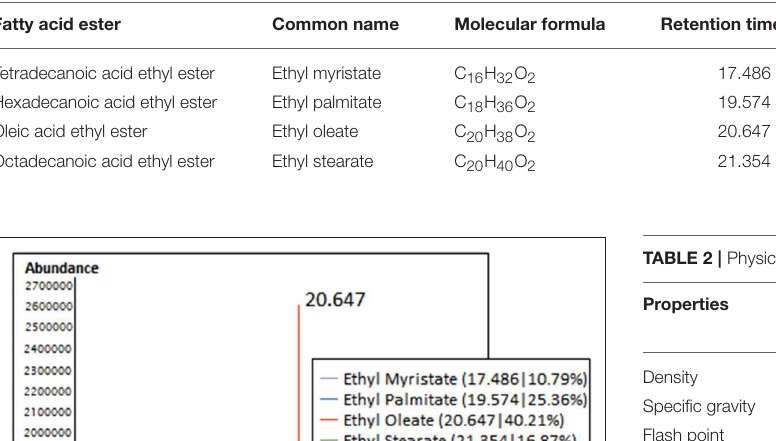
TABLE 1 | Availability of characterized dominant fatty acid esters along with their retention time and molecular weight.